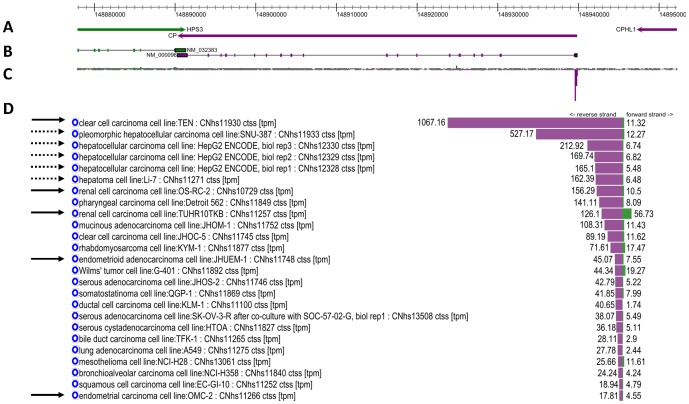
View of the ceruloplasmin (CP) locus in the human genome.A. CP is located on on the negative (purple) strand of chromosome 3 at position 3q23-q25, flanked by HPS3 on the positive (green) strand and CPHL1 on the negative strand. B. RefSeq mRNA models of the locus. C. Promoter activity signal distribution as measured by CAGE in the locus. The majority of expression comes from the 5′ end of CP. D. Expression (tags per million, TPM) across the locus for the cell lines present in FANTOM5. Cell lines with expression above 10 TPM are shown here; in total 269 cell lines were profiled. Obesity associated cell lines are indicated by black (O.R. > = 1.30) and gray (O.R. > = 1.20) arrows.